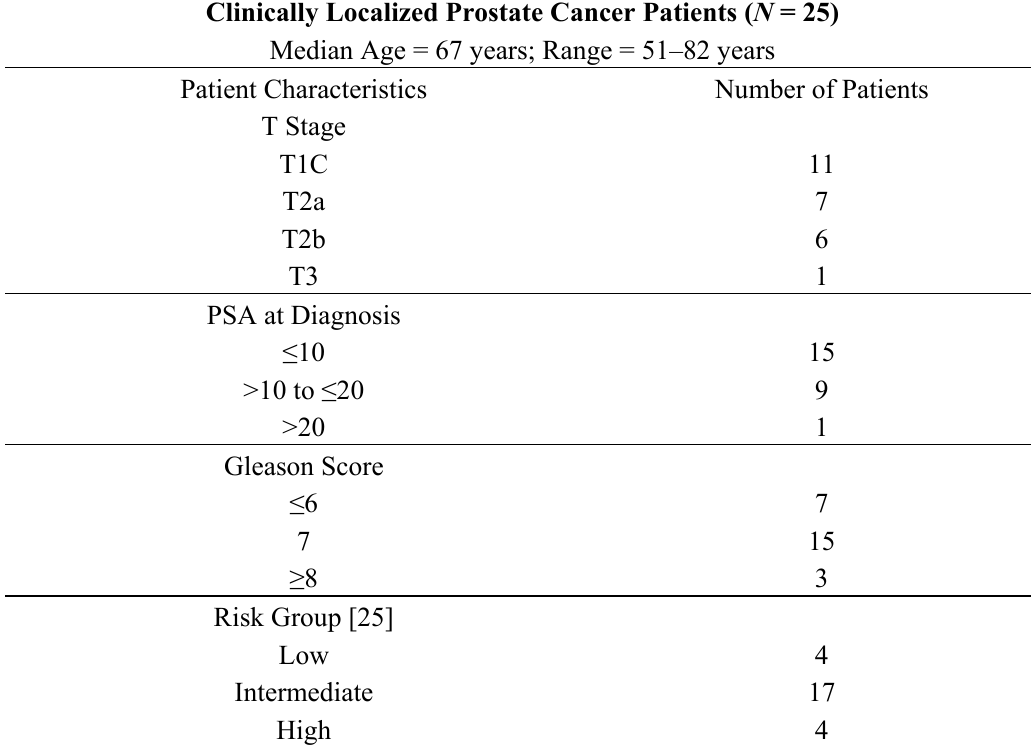
Table 4. Baseline and clinical demographics of the patients with localized PCa and mCRPC from whom plasma samples were